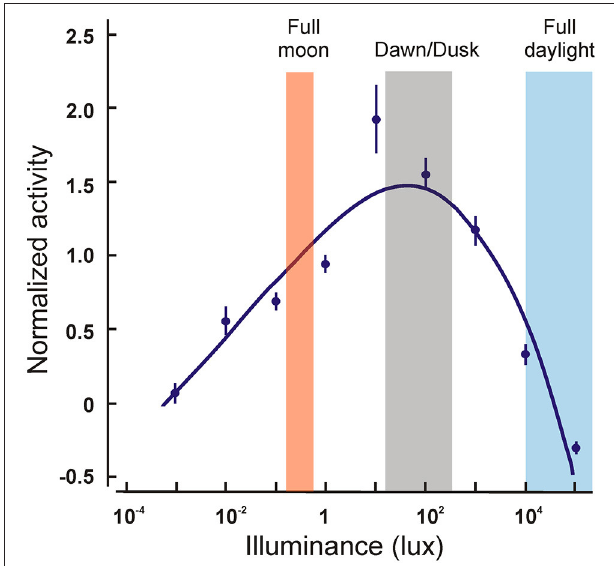
FIGURE 4 | Locomotor activity levels of wild Aotus azarai as a function of ambient illuminance levels. The points represent the averaged activity levels for nine animals. Note that the greatest activity occurs at dawn and dusk, and that some activity is still present at very dim or at very bright light levels. Data replotted from Fernandez-Duque et al.